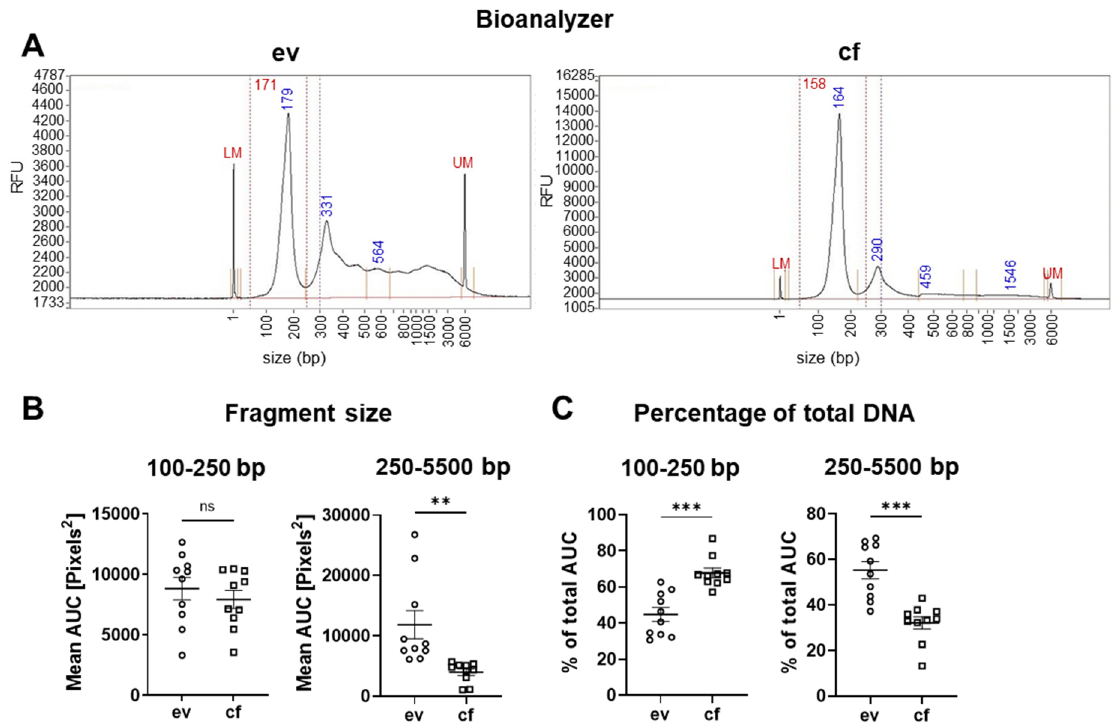
Figure 4. Analysis of DNA quality. ( A ) Exemplary bioanalyzer data of patient 10. ( B ) Statistical analysis of the mean area under the curve (AUC) for ev- and cfDNA in a range of 100 to 5500 bp. ( C ) Percentage amount of DNA fragments of total DNA in a range of 100 to 5500 bp for ev- and cfDNA. Statistical tests: ( B , C ) Two-tailed unpaired Student t -test; ** p < 0.01; *** p < 0.001; ns: no significant difference.